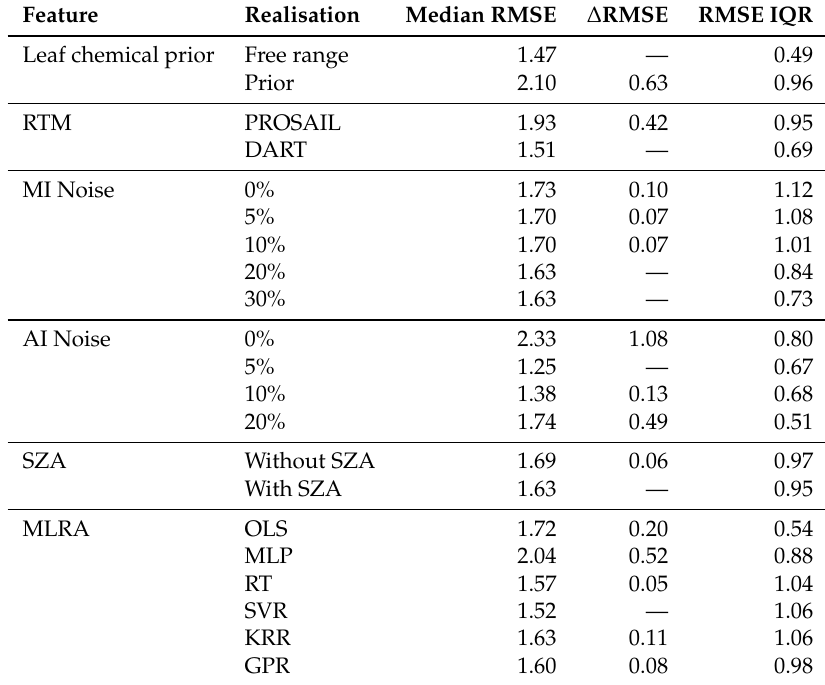
Table 3. Validation median RMSE and Interquartile Range (IQR) (25 to 75%) for training features. ∆ RMSE refers to the difference to the best feature per